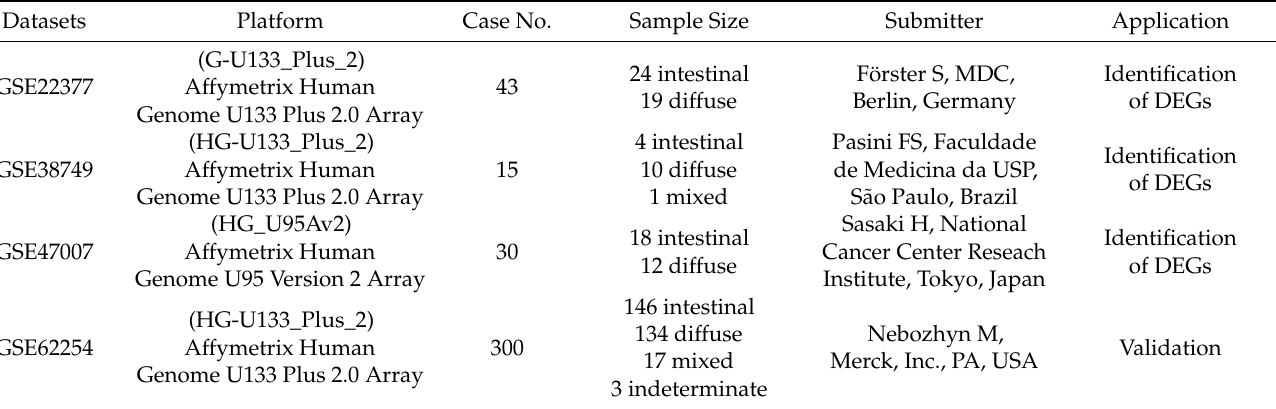
Figure 1. Flowchart showing the process of establishing the gene signature and prognostic nomogram of diffuse-type gastric cancer in this study. Table 1. Details of GEO datasets in this study.